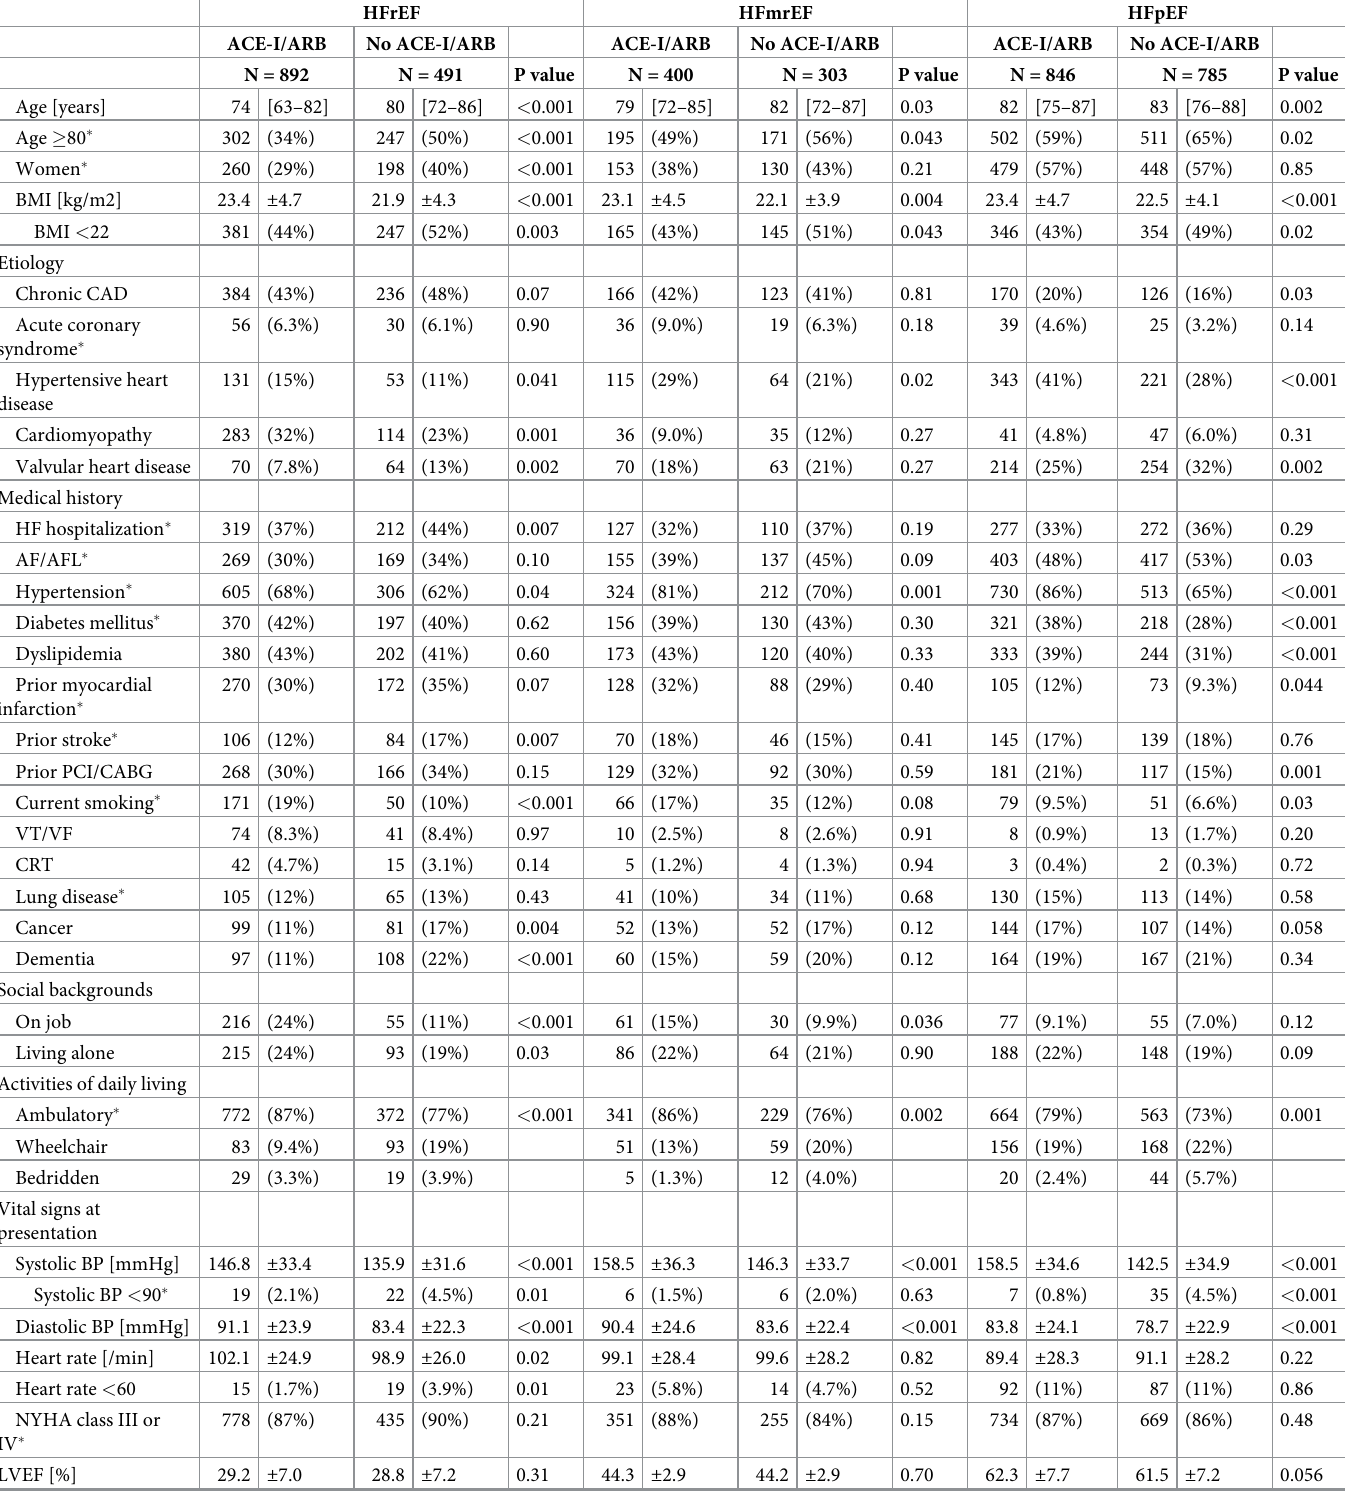
Table 2. Baseline characteristics stratified by the LVEF categories: ACE-I/ARB versus no